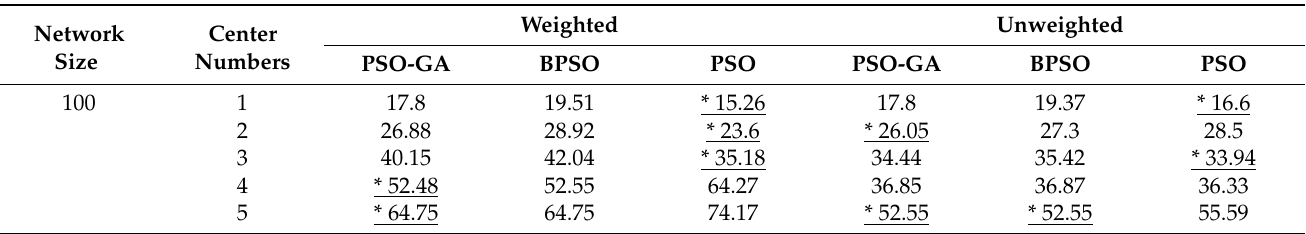
Table 7. Solution time (Unit: s) for weighted and unweighted center locations